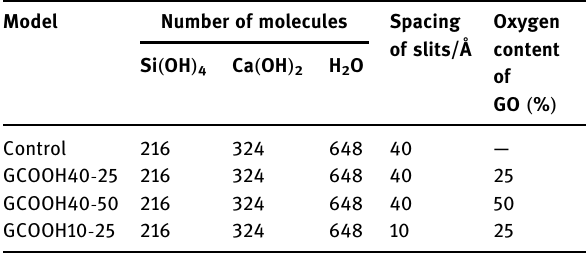
Table 1: Model system components and related parameters Model